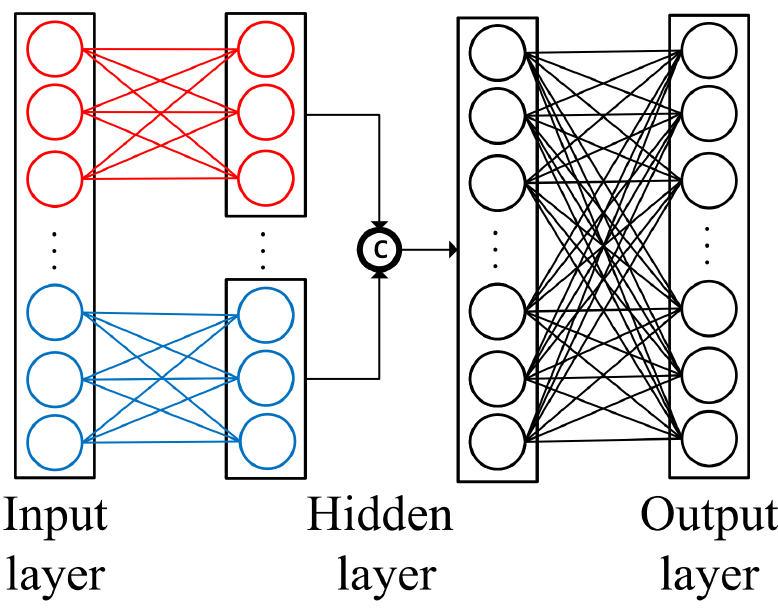
Figure 2. Illustration of the proposed disentangle regressor; C denotes concatenate